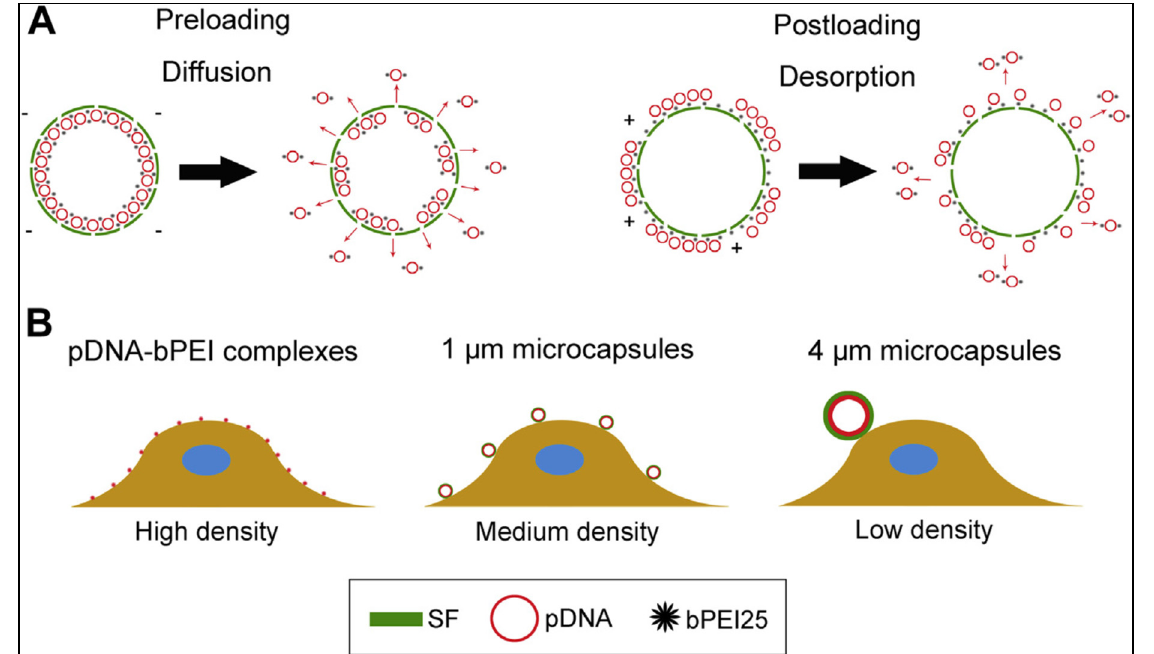
Figure 4. The results of various loading methods and measures of pDNA loaded SF micro capsules on release activity and cell capsule interactions are depicted in this diagram. ( A ) Preloading: pDNAebPEI complexes are released from SF capsules through diffusion. After charging, desorption from its membrane of SF capsules releases complexes. ( B ) For the same total amount of pDNA, varying sizes of gene carriers have various transmission densities on the cell surface, affecting cell viability and transfection. Reprinted with permission from reference [97].